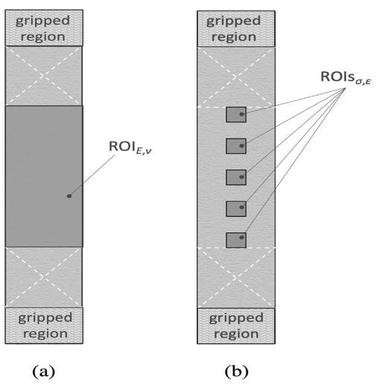
Regions of interest selected for the calculation of the Young's moduli and Poisson's ratios (a); and for the determination of the stress–strain parameters (b).